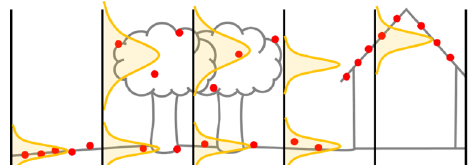
Figure 1. Schematic visualisation of our proposed algorithm using height distributions as input for classification. Gray: underlying objects, black: raster grid, red: measured points in the point cloud, yellow: calculated height distributions for each